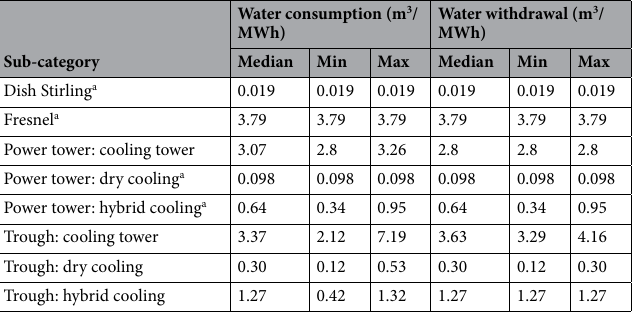
Table 11. CSP-generated power plant’s water withdrawal and consumption data 69 . a Reflecting data limitations and the nature of water use, we assume withdrawal and consumption are equal for all estimates in this category.